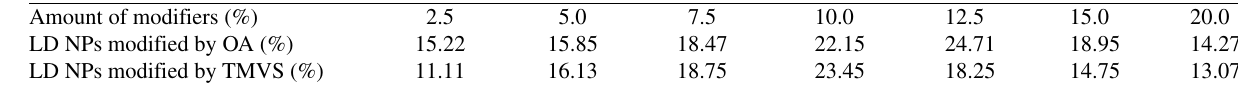
Table 1: The LD of alumina NPs modified by oleic acid (OA) and TMVS (%) in different amount of modifiers. Amount of modifiers (%) LD NPs modified by OA (%) LD NPs modified by TMVS (%)